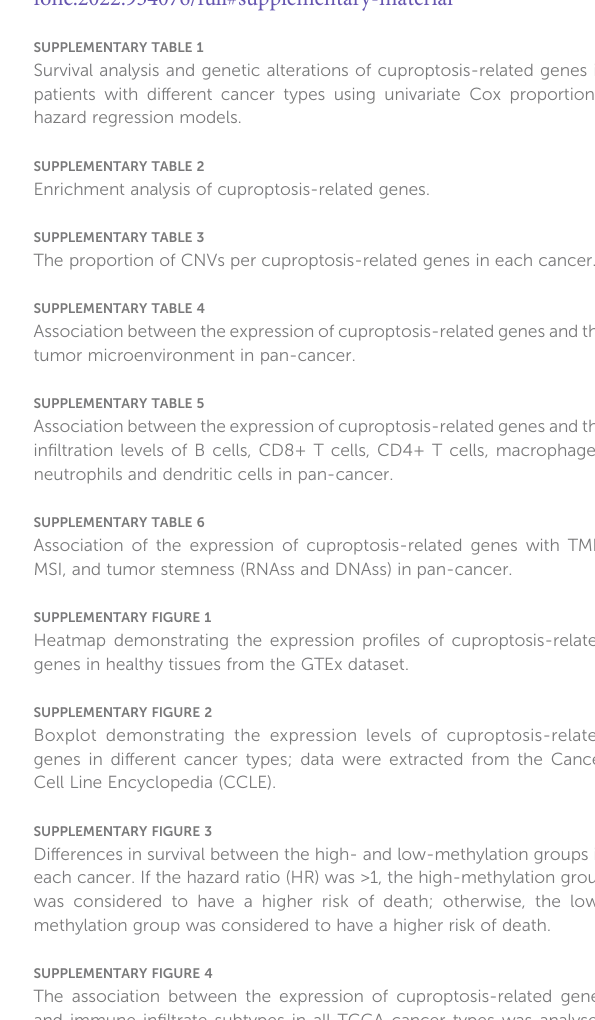
SUPPLEMENTARY TABLE 1 Survival analysis and genetic alterations of cuproptosis-related genes in patients with different cancer types using univariate Cox proportional hazard regression models. SUPPLEMENTARY TABLE 2 Enrichment analysis of cuproptosis-related genes. SUPPLEMENTARY TABLE 3 The proportion of CNVs per cuproptosis-related genes in each cancer. SUPPLEMENTARY TABLE 4 Association between the expression of cuproptosis-related genes and the tumor microenvironment in pan-cancer. SUPPLEMENTARY TABLE 5 Association between the expression of cuproptosis-related genes and the